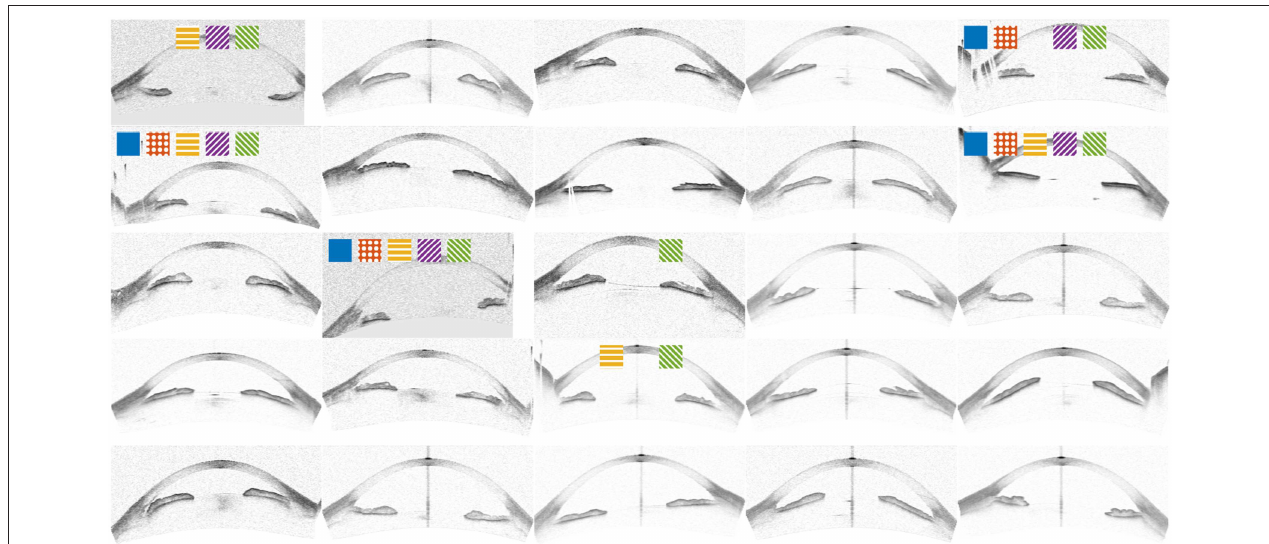
FIGURE 2 | Example images from the OCT database, all except the first one were randomly sampled. Marked images correspond to top 15% outlier score for OCSVM (Blue), distance to center of mass (Orange), IsoMap (Yellow), Percolation (Purple), and Ramaswamy (Green). The first image corresponds to the marked improvement in Figure 4